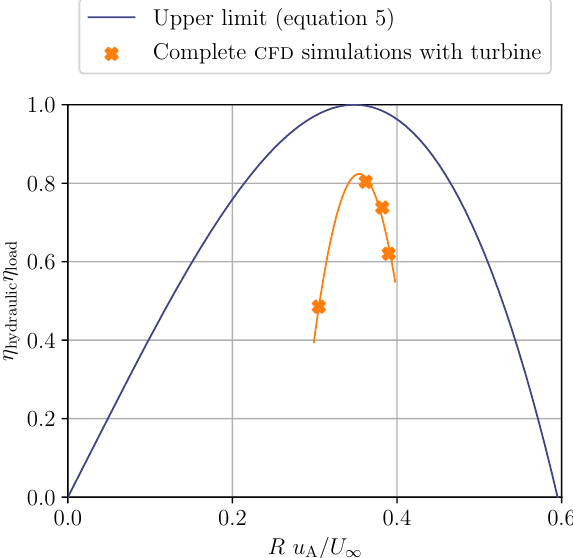
Figure 9. The data from Figure 8, this time presented so that the efficiency of the power extraction (the product of the load efficiency η load and hydraulic efficiency η hydraulic ) is quantified; the reference power for this is the maximum of the power curve.